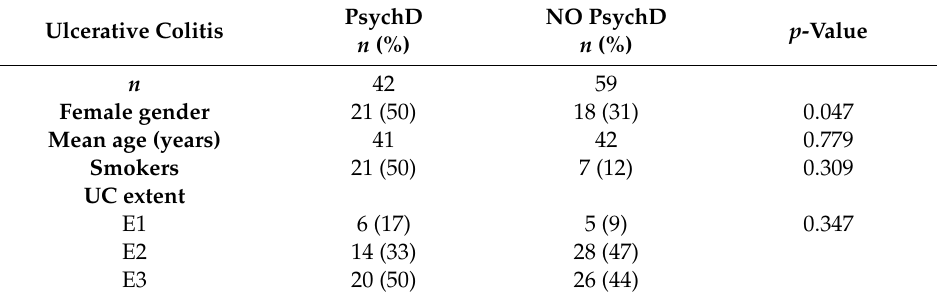
Table 3. Demographic and clinical characteristics of ulcerative colitis (UC) patients with and without any current psychiatric disorders